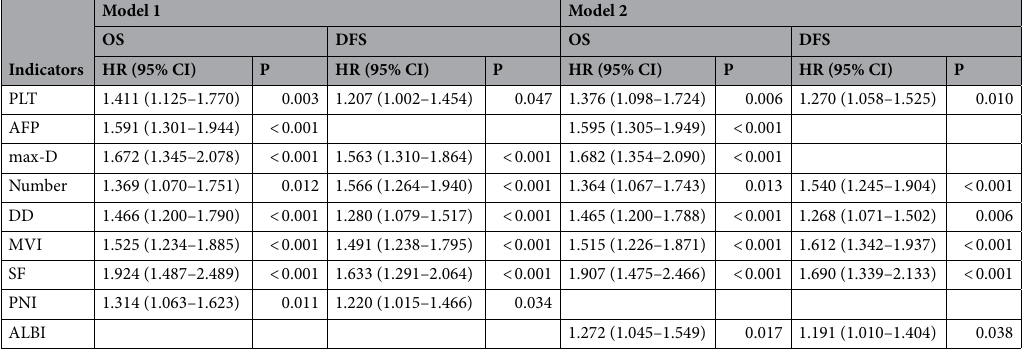
Table 4. Prognostic models for DFS and OS by Cox multivariate regression analysis. (Model 1: variables that were independent risk factors of PNI were included; Model 2: variables that were independent risk factors of ALBI were